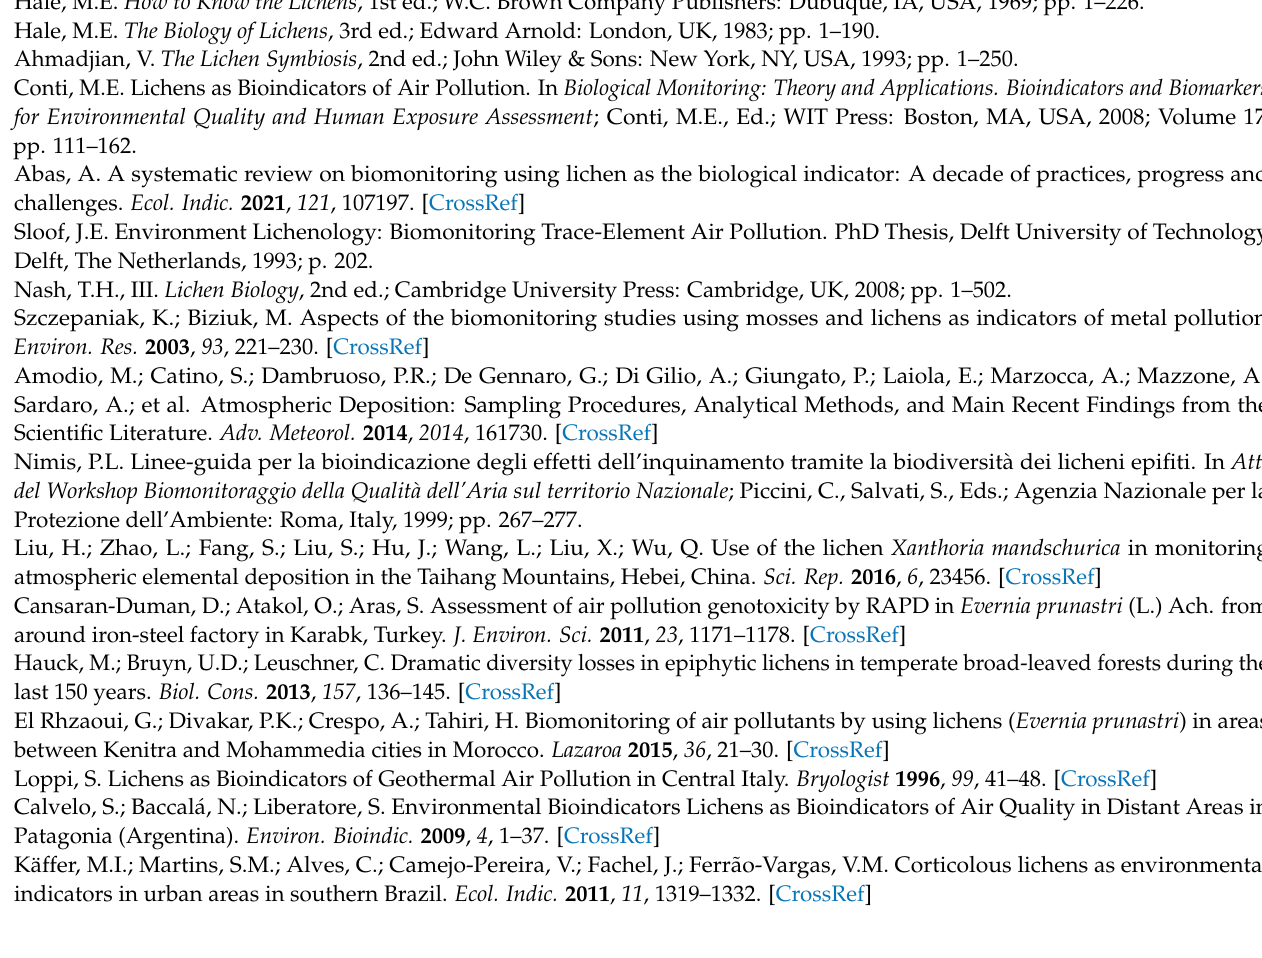
Table 1. Spectra are given in Figure